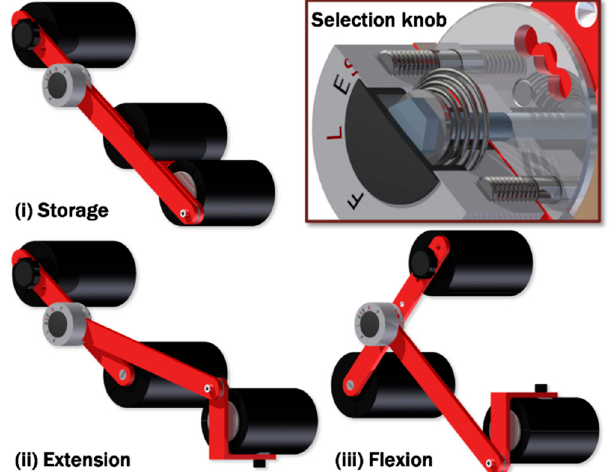
Figure 1. Limb strength measurement device (LSMD) in storage ( i ), extension ( ii ), and flexion ( iii ) configurations. Inset: Spring-loaded selection knob allows user to change between configurations.